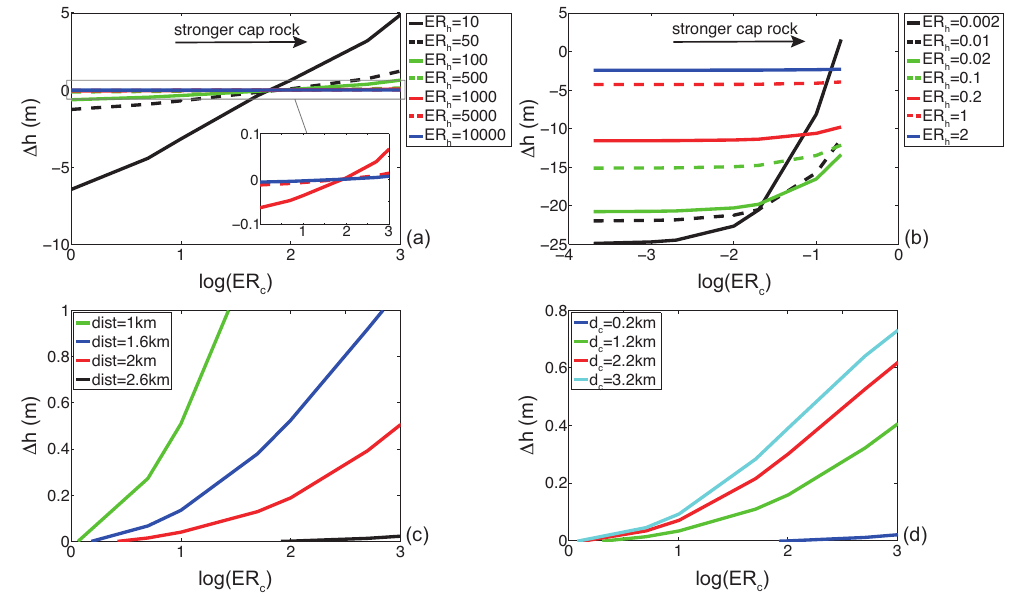
Figure 6. Influence of the elastic stratigraphy on the central, initial hydraulic head change, shown using the ratios of Young’s Moduli ER c = E c , and ER h = E h . (a) Pyroclastic aquifer, (b) lava flow aquifer. Also shown is the behaviour of central initial head change in the E aq E aq pyroclastic aquifer with ER c for different distances between chamber and aquifer (c) and the behaviour of central initial head change in the pyroclastic aquifer with ER c for different cap rock thicknesses (d)